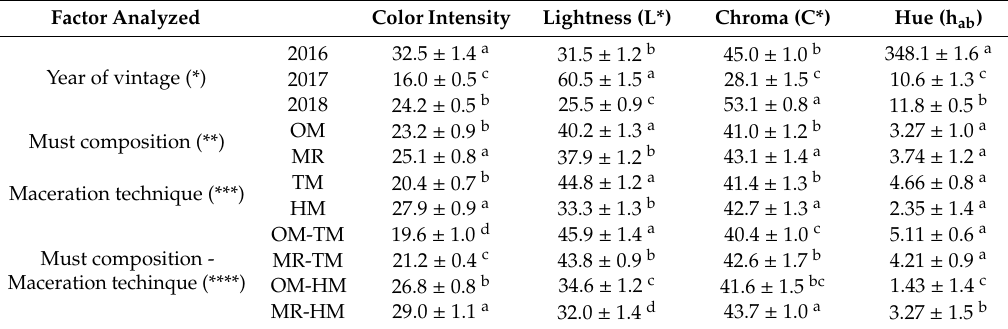
Table 4. Color of the